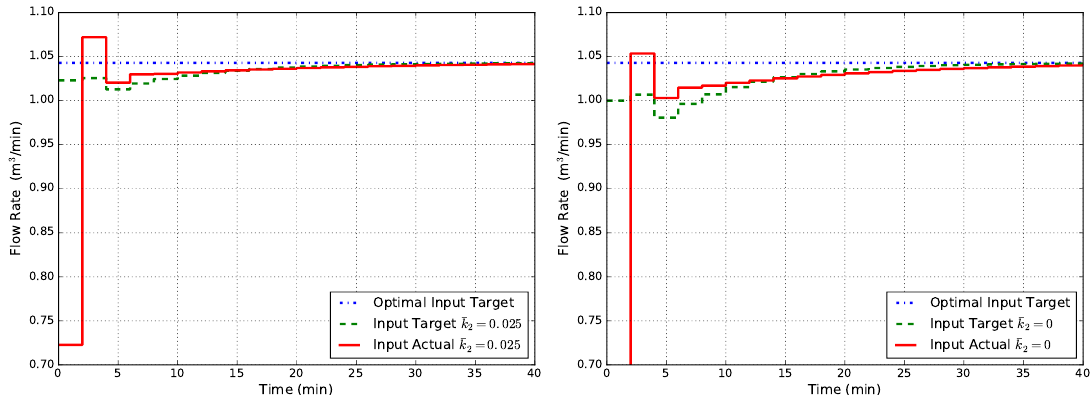
Figure 8. Closed-loop flow rate Q obtained with EMPC1-MT-MD (state disturbance model, modified target problem, modified FHOCP) for two cases of uncertainty in k 2 : ¯ k 2 = 0.025 ( left ) and ¯ k 2 = 0 ( right